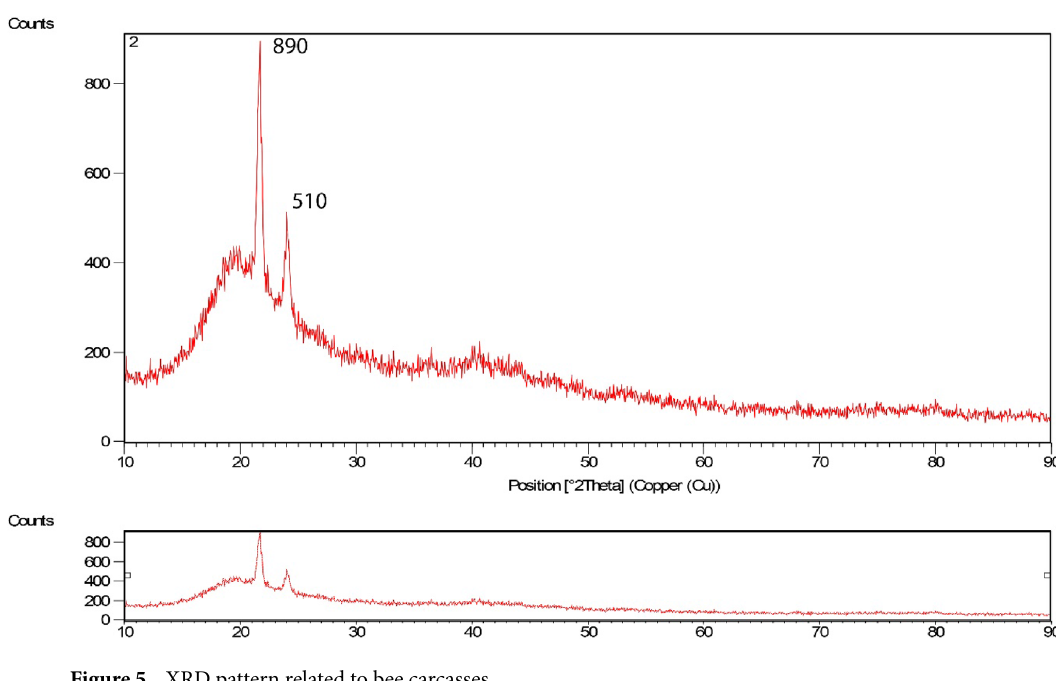
Figure 5. XRD pattern related to bee